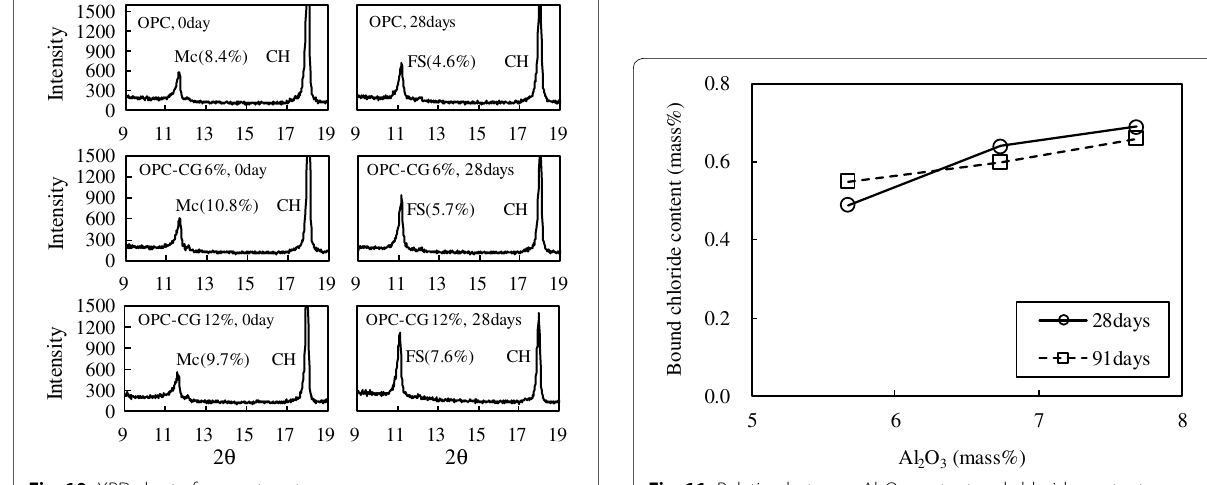
2 O 3 content and chloride